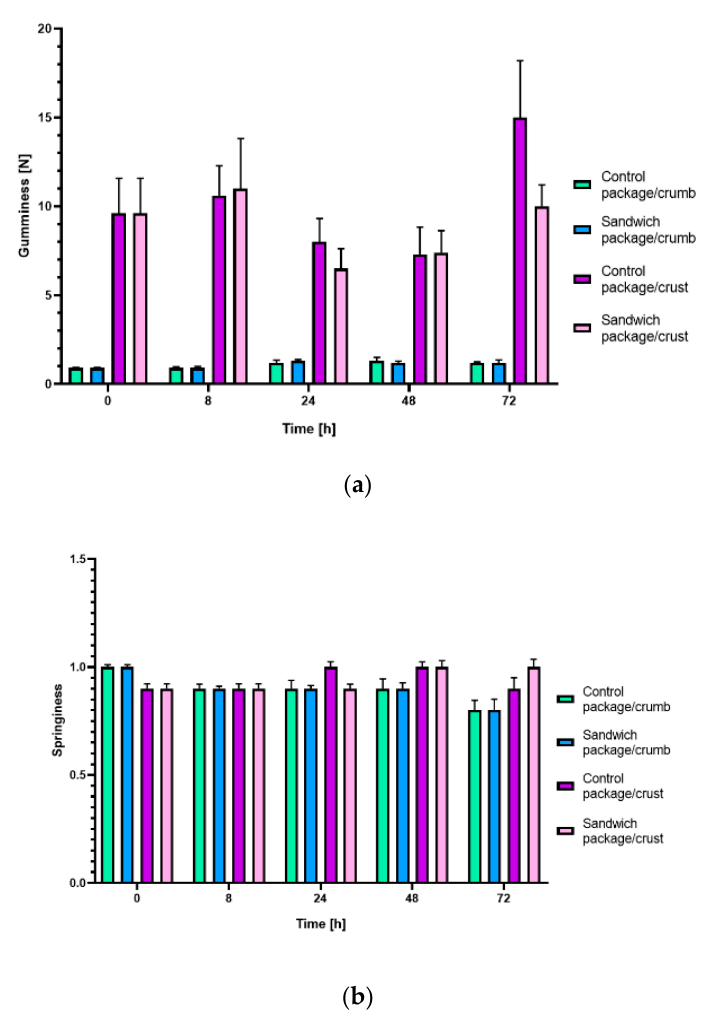
Figure 5. ( a ) Gumminess of the crust and crumb after storage in paper and in the modified package. ( b ) Springiness of the crust and crumb after storage in paper and in the modified package.